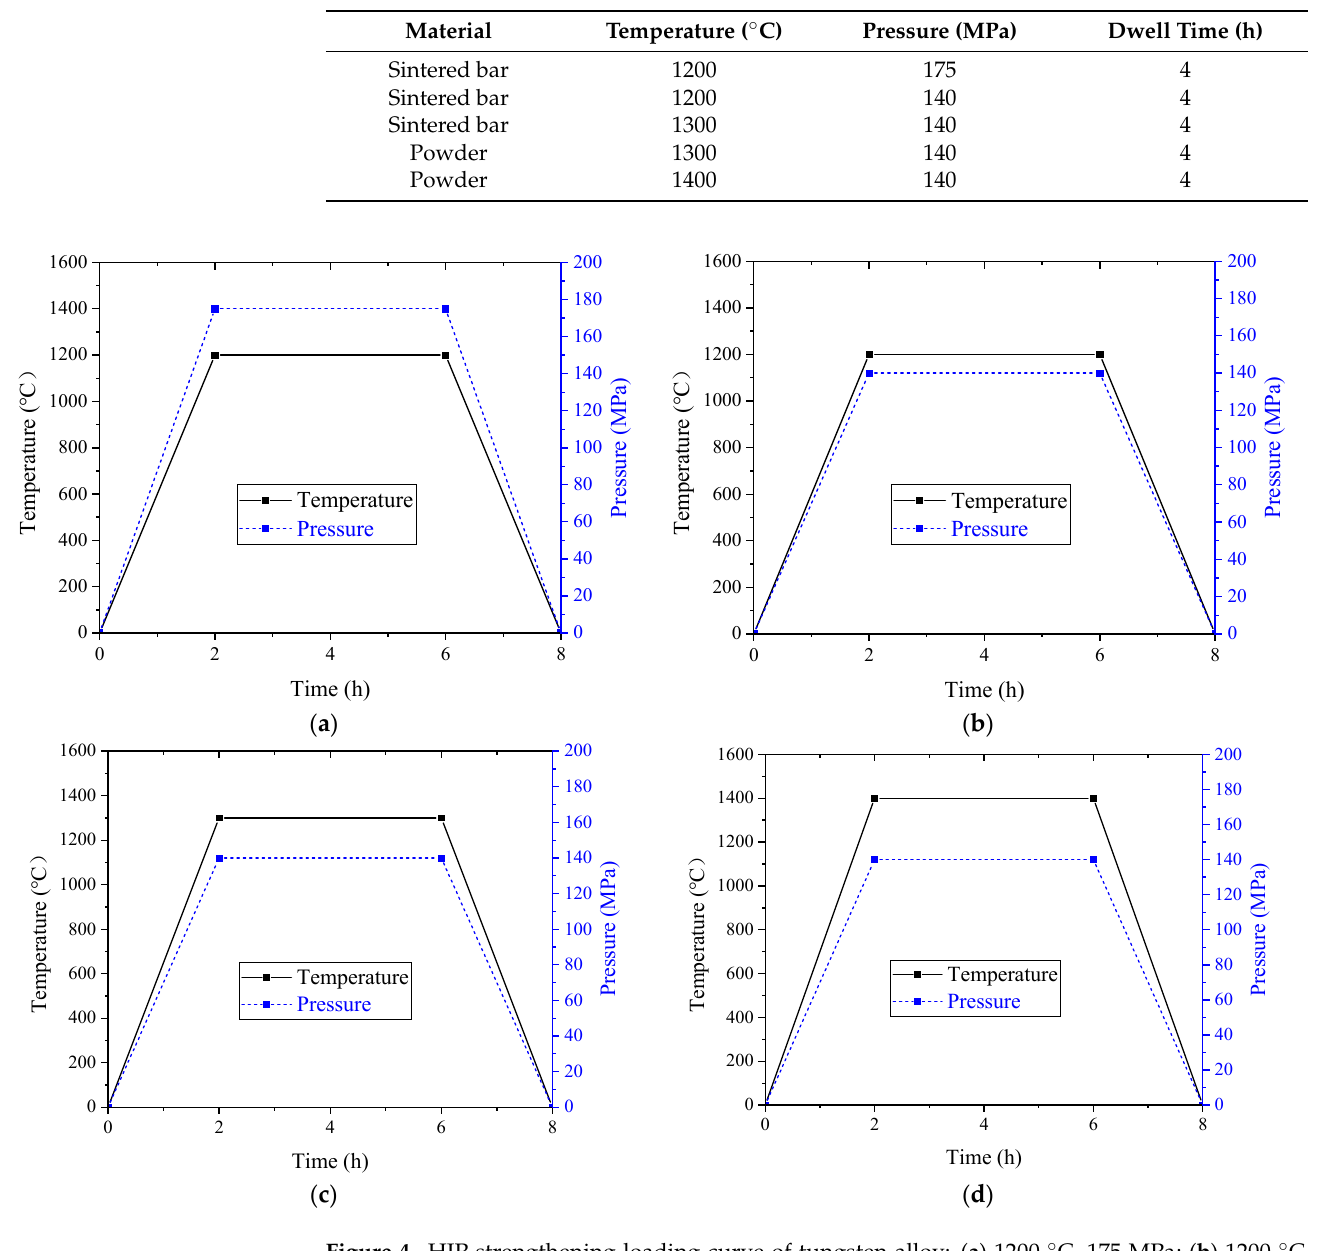
Table 3. The process parameters of HIP.